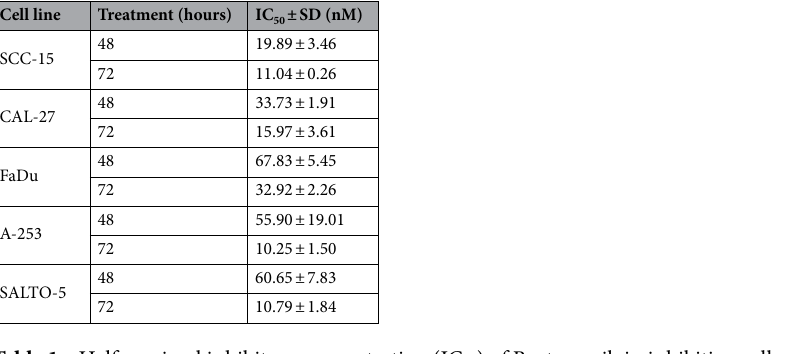
Table 1. Half maximal inhibitory concentration (IC 50 ) of Bortezomib in inhibiting cell growth of SCC-15, CAL-27, FaDu, A-253 and SALTO-5 cell lines after 48 and 72 h of treatment.